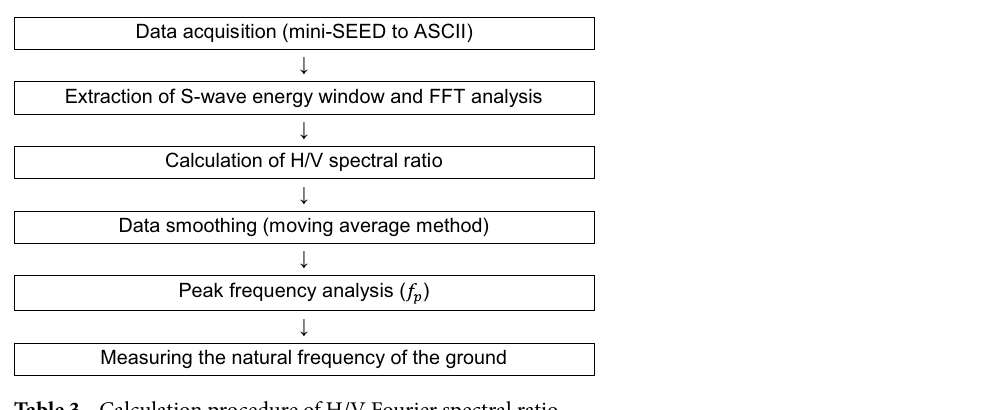
Table 3. Calculation procedure of H/V Fourier spectral